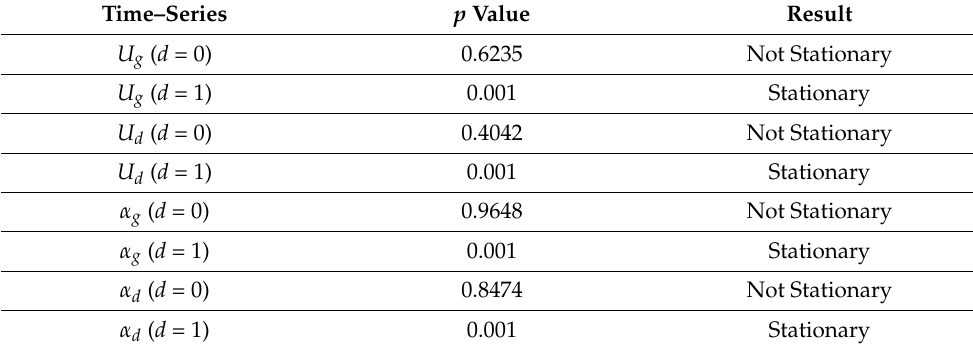
Table 3. AIC, BIC values of different ARIMA